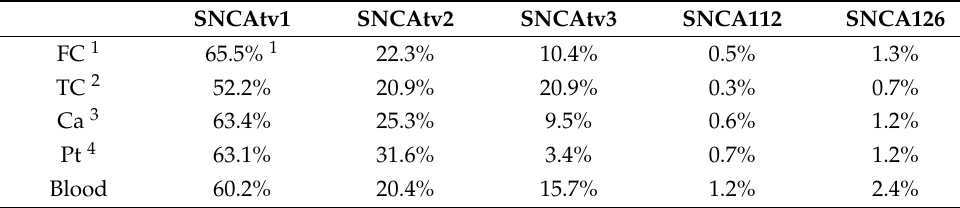
Table 3. Relative expression of SNCA isoforms in four different brain regions and blood.